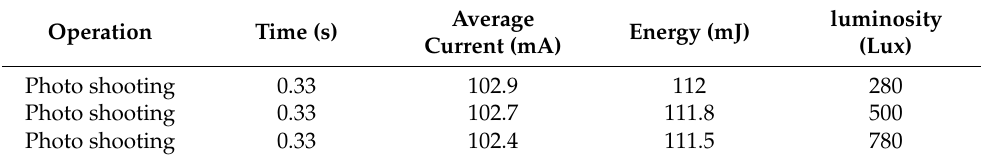
Table 5. Energy vs. luminosity.